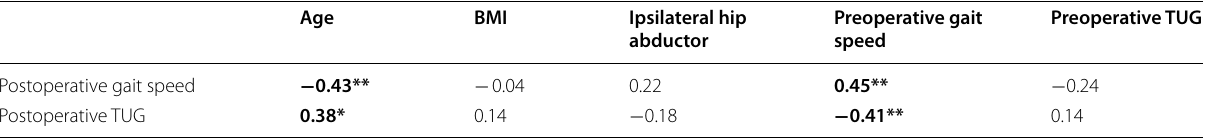
BMI Body mass index, TUG Timed Up-and-Go test. Values highlighted in bold are statistically significant (* P < 0.05 and ** P < 0.01) Table 5 Stepwise regression analysis for postoperative gait function